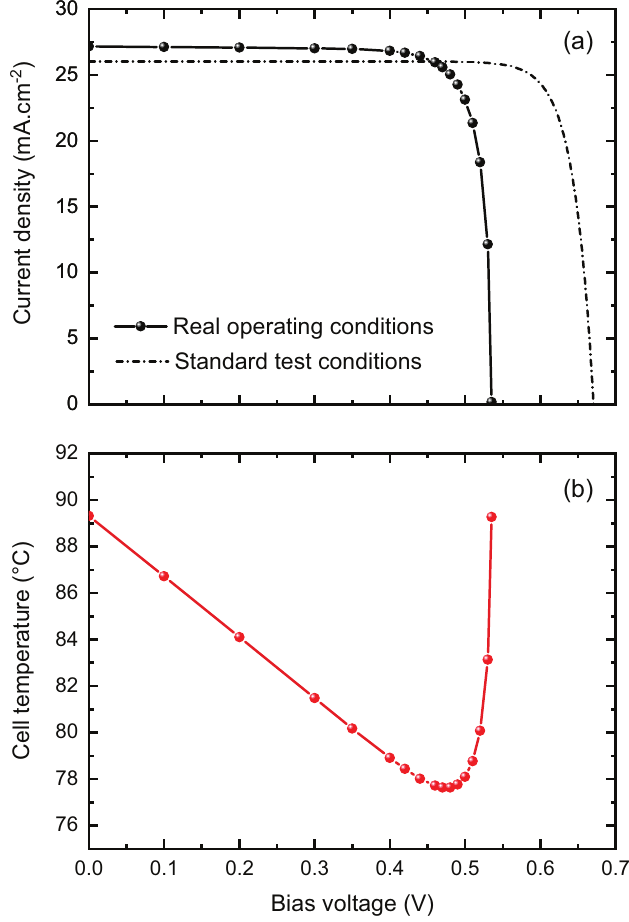
Fig. 3. Solar cell current – voltage (a) and temperature – voltage (b) characteristics simulated in real operating conditions. The current – voltage characteristic under STC ( T =25 ° C regardless of the bias voltage) is also shown as a dotted line in the upper fi